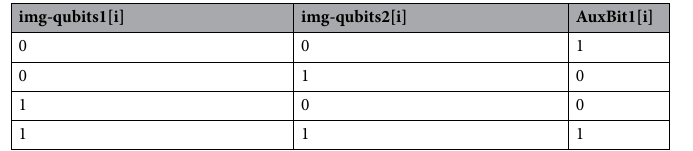
Table 1. Truth table for comparing two qubits. The value of AuxBit1[i] would be set to 1 only if the values of img-qubits1[i] and img-qubits2[i] are the same.